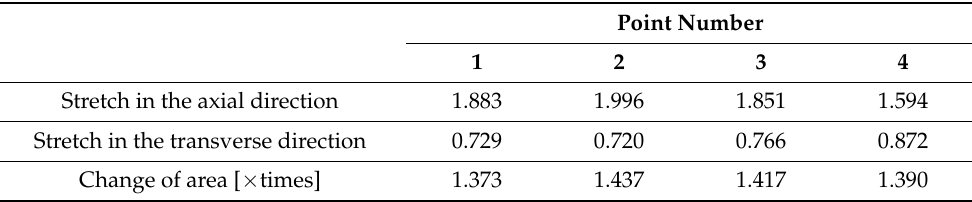
Table 2. The parameters of the sample after